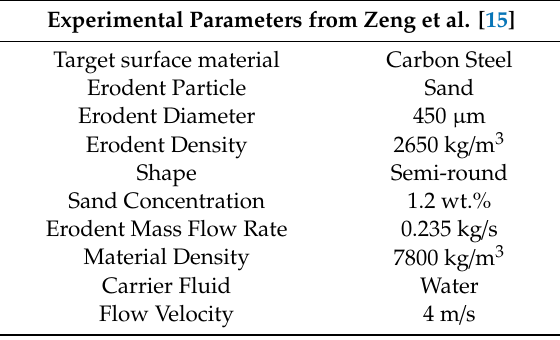
Table 4. Flow conditions for validation case.